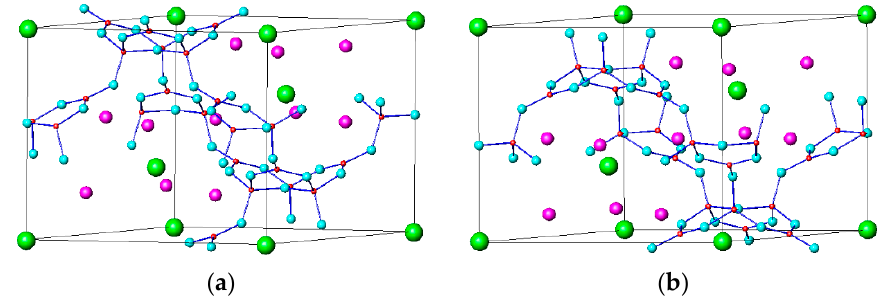
Figure 1. The crystal structure of K 3 B 6 O 10 Br ( a ) and its inversion twin ( b ). Crystals 2017 , 7 , 50